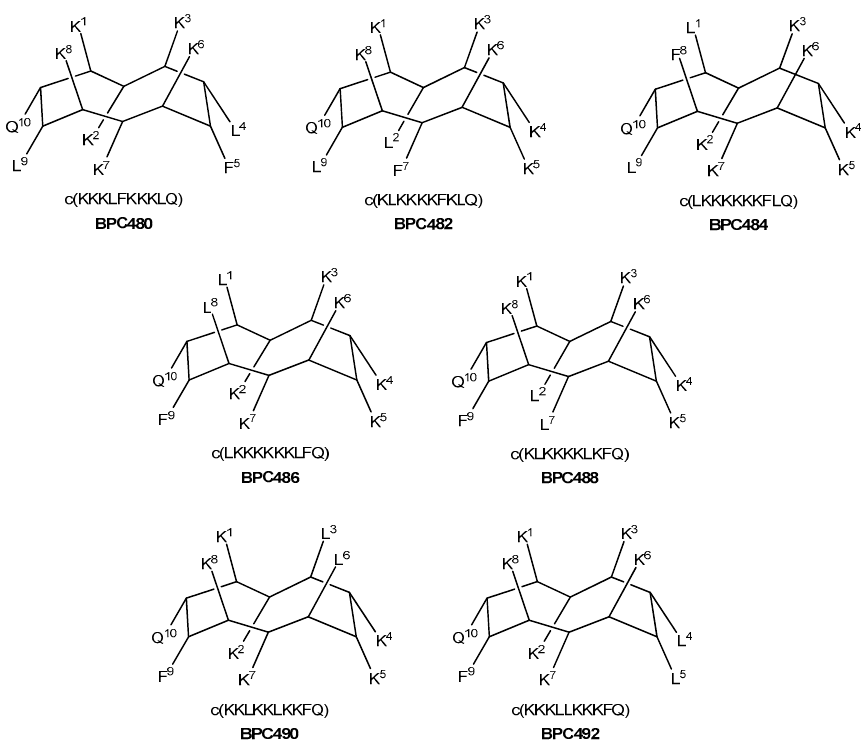
Figure 6. Sequence and hypothetic structure of the BPC194 analogues.